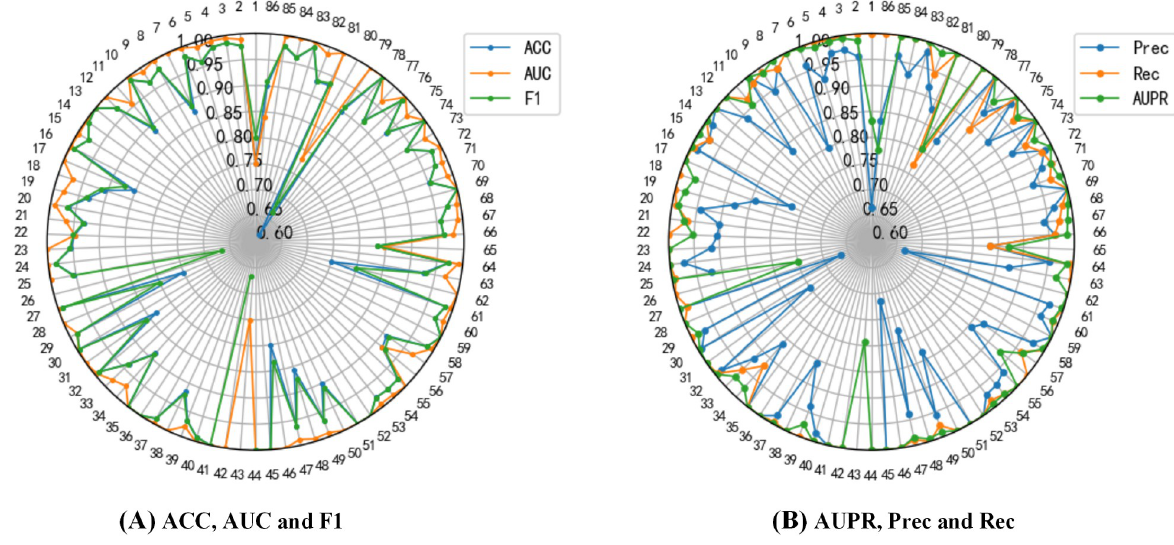
Fig 9. Performance for each DDI